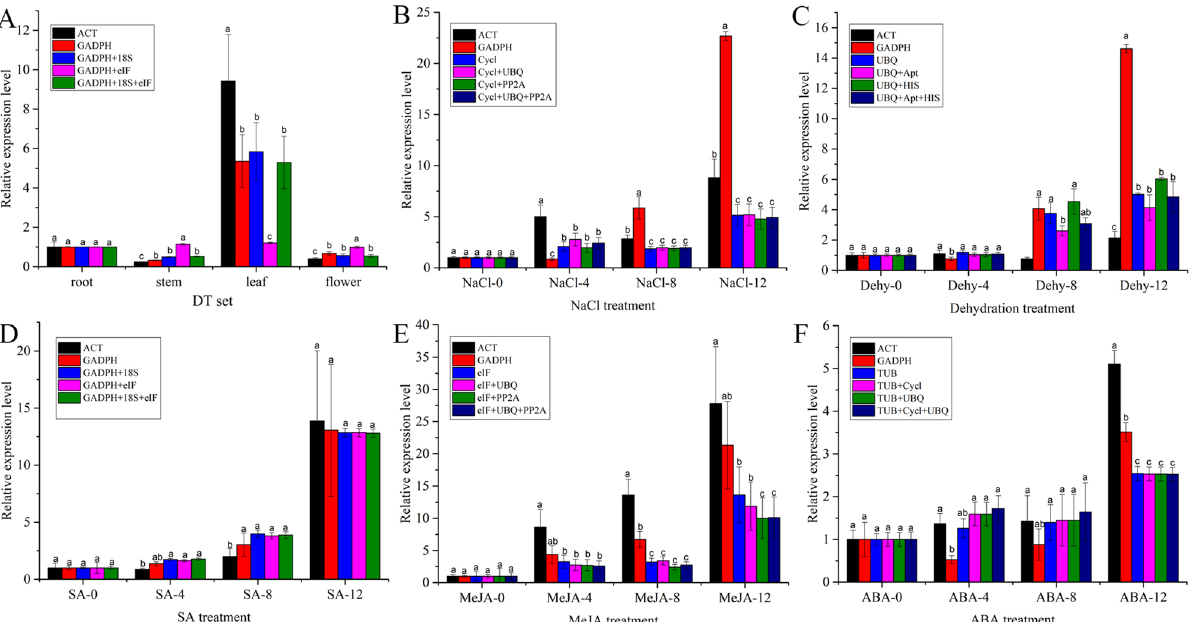
Figure 7. Relative expression levels of HMGR in I. rubscences . The expression of HMGR in I. rubscences in different tissues ( A ), under NaCl ( B ), dehydration ( C ), SA ( D ), MeJA ( E ) and ABA ( F ) treatments. Genes were normalized to ACT or GADPH or a combination of the two or three top ranked genes defined by the RefFinder and RankAggreg analysis. All values are means ± SD (n = 3). Different letters on the bar indicate a significant difference at p <